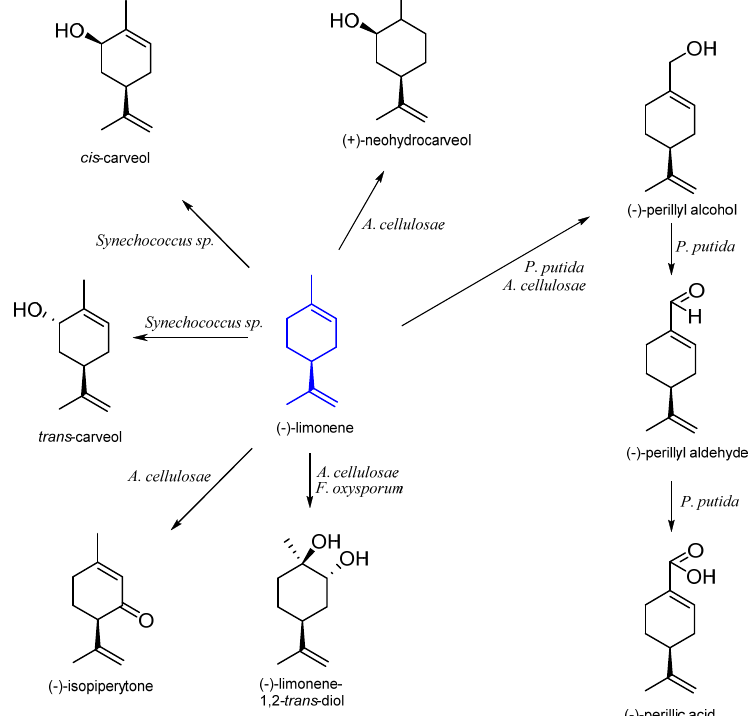
Scheme 1. Biotransformation of (+)-limonene. Table 1. Biotransformation of